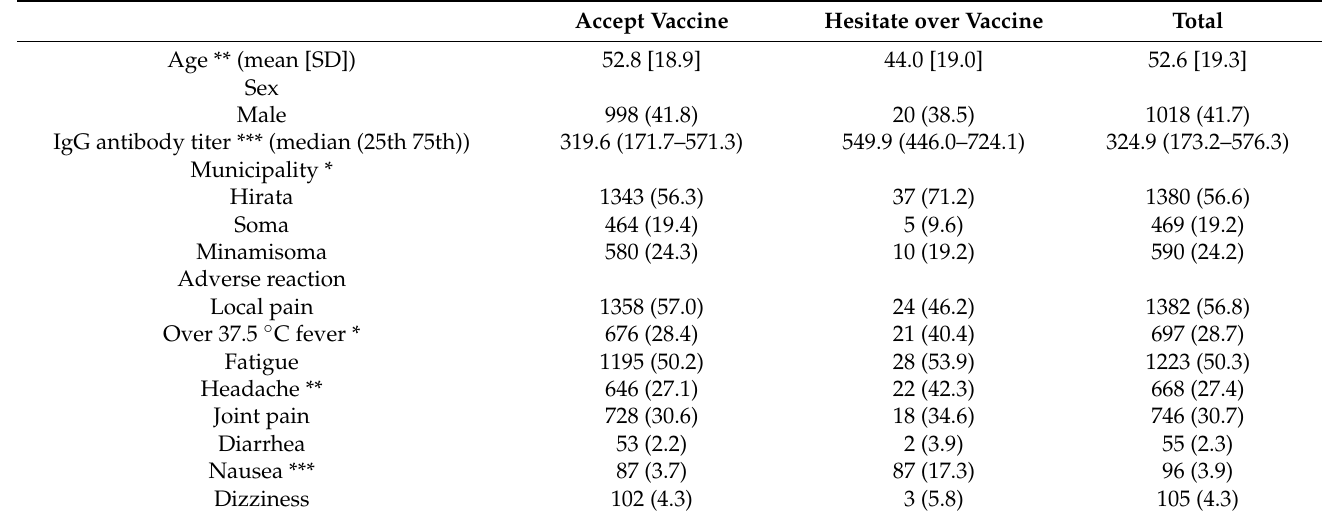
Table 1. Characteristics of the participants based on willingness to accept the third COVID-19 vaccine dose n (%) ( n = 2439).